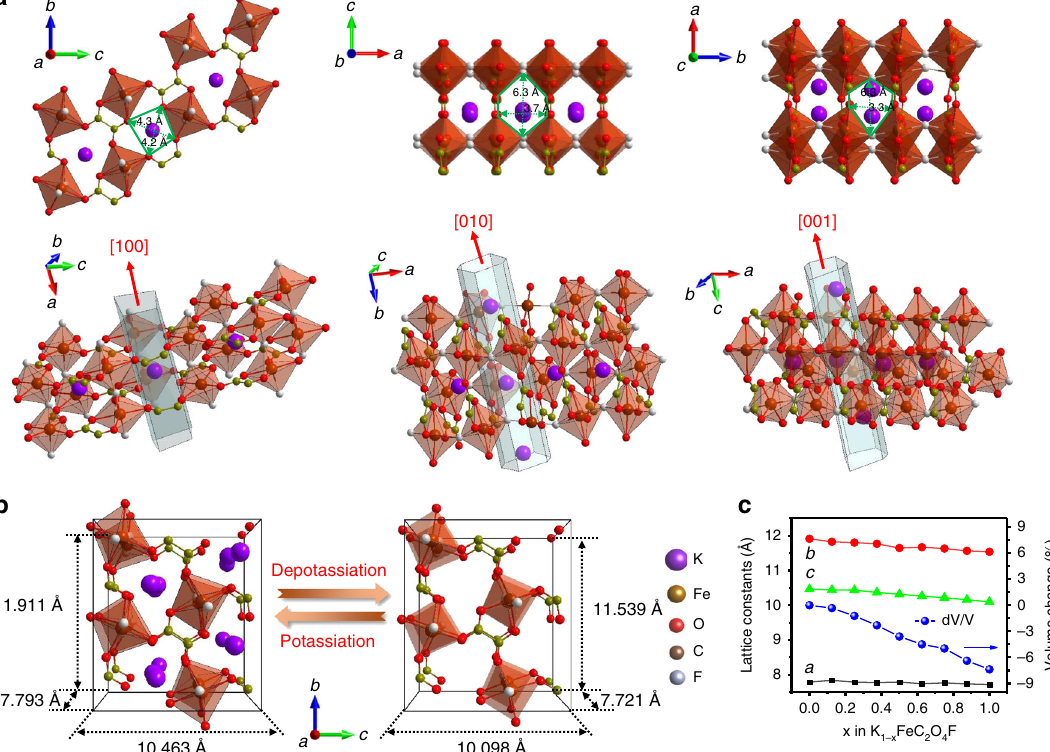
Fig. 4 The structure of the KFeC 2 O 4 F cathode. a Projections of the KFeC 2 O 4 F structure along the [100], [010], and [001] directions and corresponding tunnels for possible ion migrations, with tunnel size highlighted. [FeO 4 F 2 ] octahedra are represented in brown. b Unit cell of KFeC 2 O 4 F in potassiation/ depotassiation states based on DFT calculation. c The lattice parameters and volume change of K 1 – x FeC 2 O 4 F as a function of the charge state x